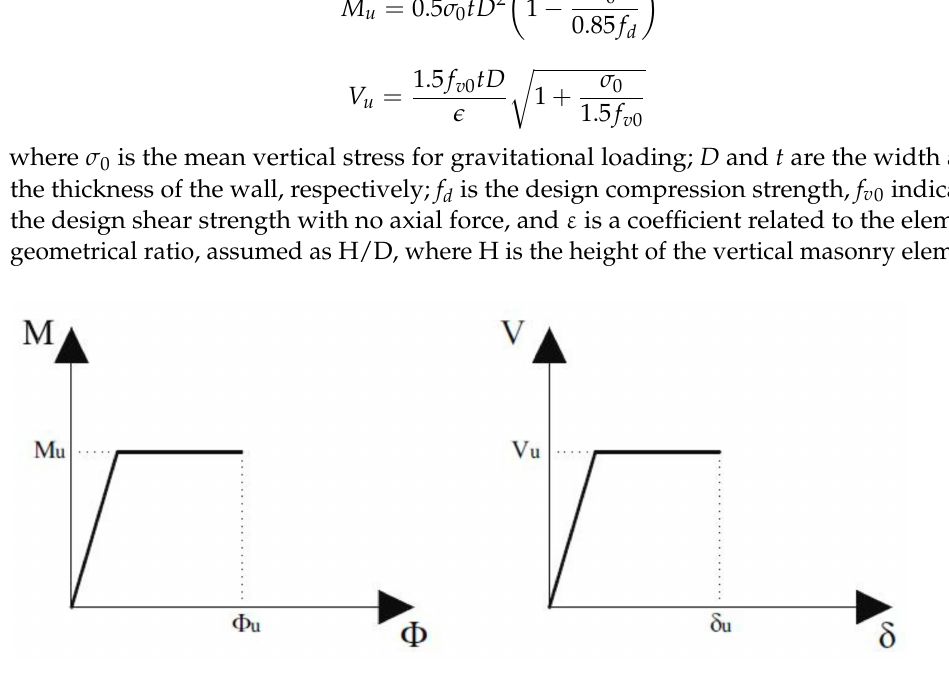
Figure 6. Constitutive laws of plastic